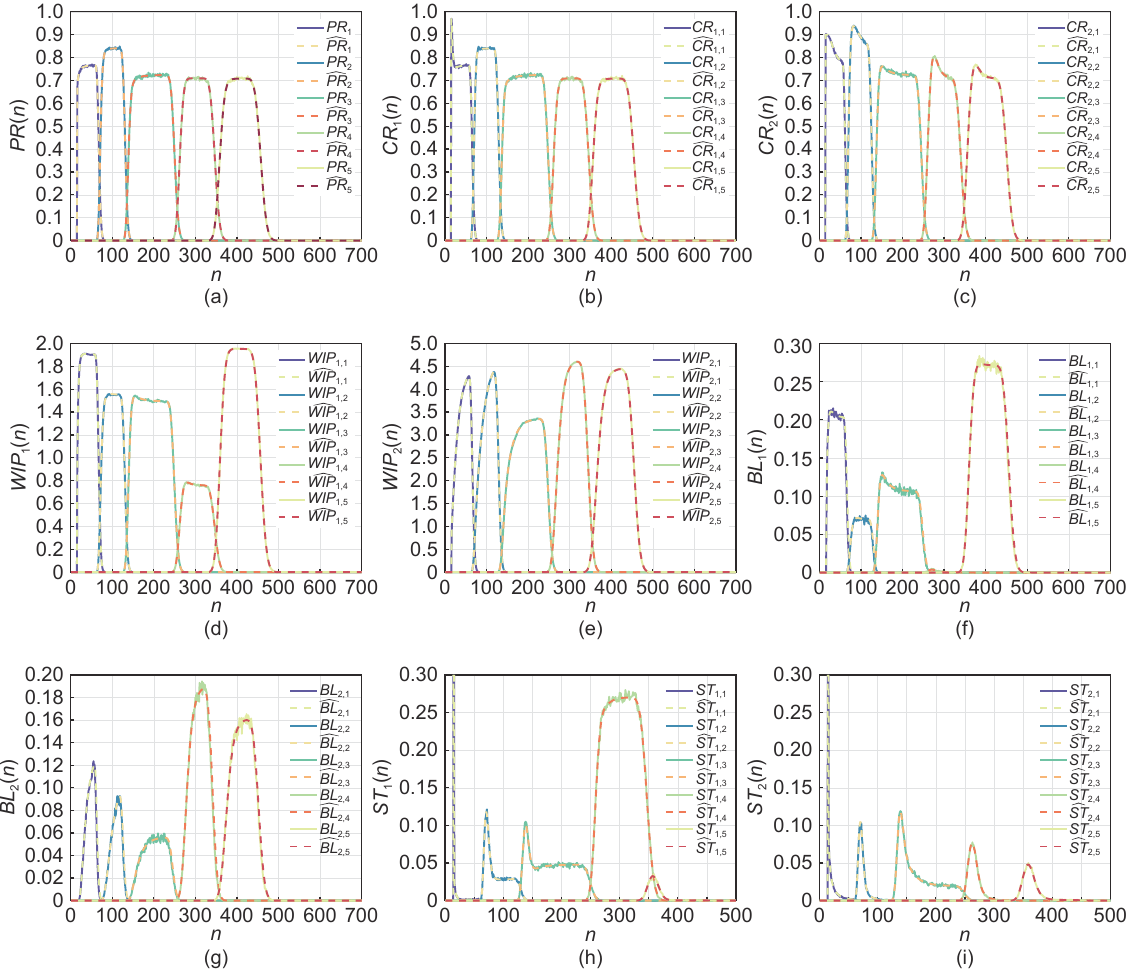
Fig. 3 Transient performance of three-machine assembly